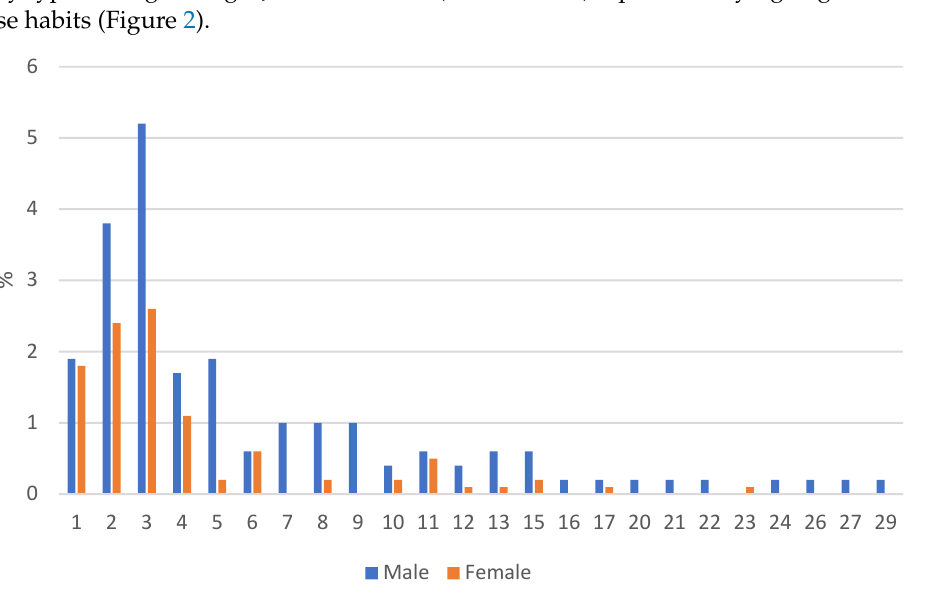
Figure 2. Frequency of total DUDIT scores in Swedish high school student sample by gender ( n = 203), excluding the 84.9% of the sample that indicated no drug use at all (scored as 0). According to the total DUDIT scores, there was a small but significant effect size ( p < 0.001, η 2 = 0.027) difference between male students’ (total DUDIT score M = 1.38, SD = 3.81) and female students’ (total DUDIT score M = 0.46, SD = 1.92) drug use habits. The proportions of male and female students engaging in drug use also differed significantly ( p < 0.001), with a higher proportion of male students ( n = 116; 22.3%) than of female students ( n = 87; 10.6%) indicating this behavior.